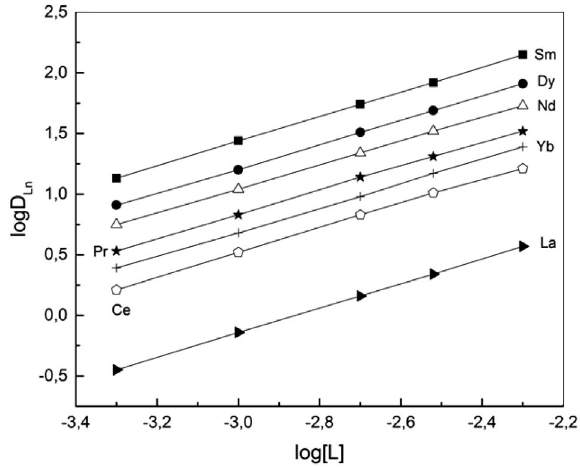
Figure 5. The effect of compound III concentration in toluene con- taining 0.01 M HP on the extraction of lanthanides(III) at pH =